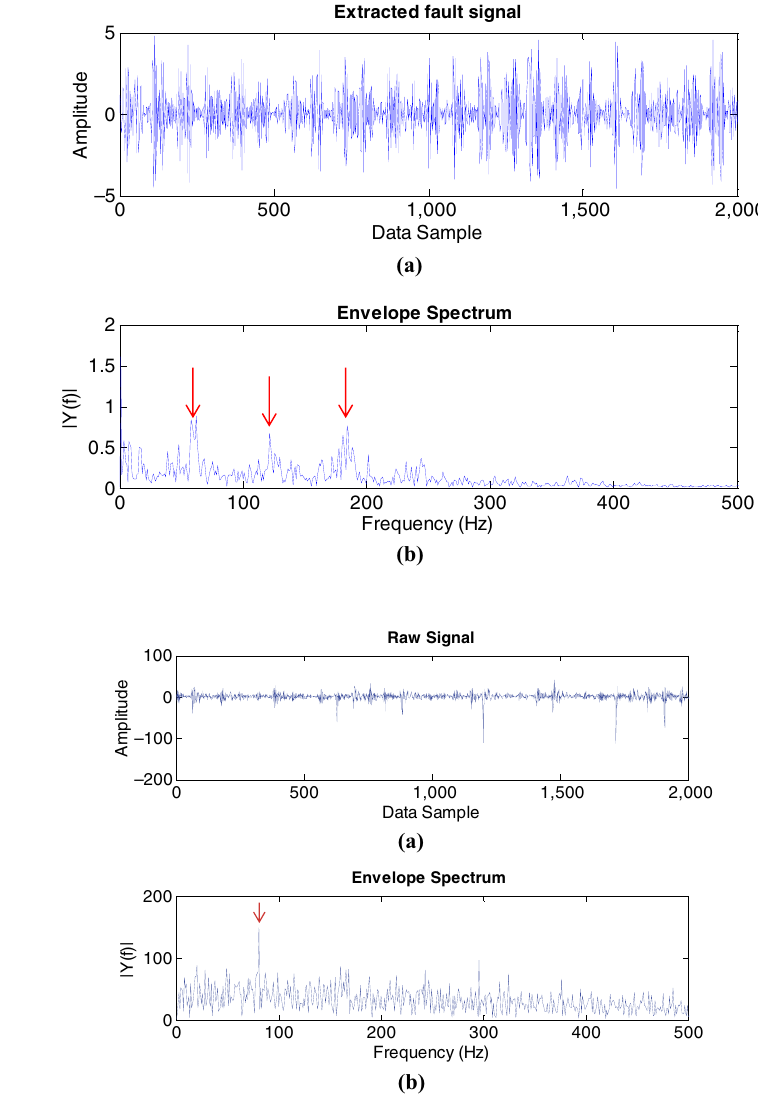
Figure 9. Envelope analysis of the inner race